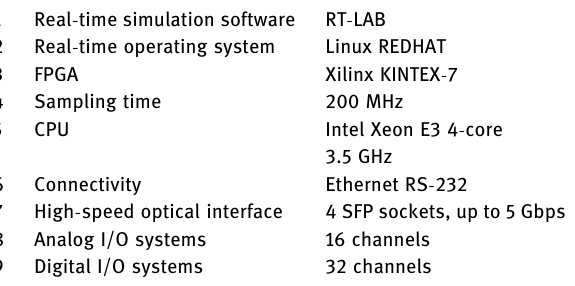
Table 3: Speci fi cations of OPAL - RT 4510 simulator